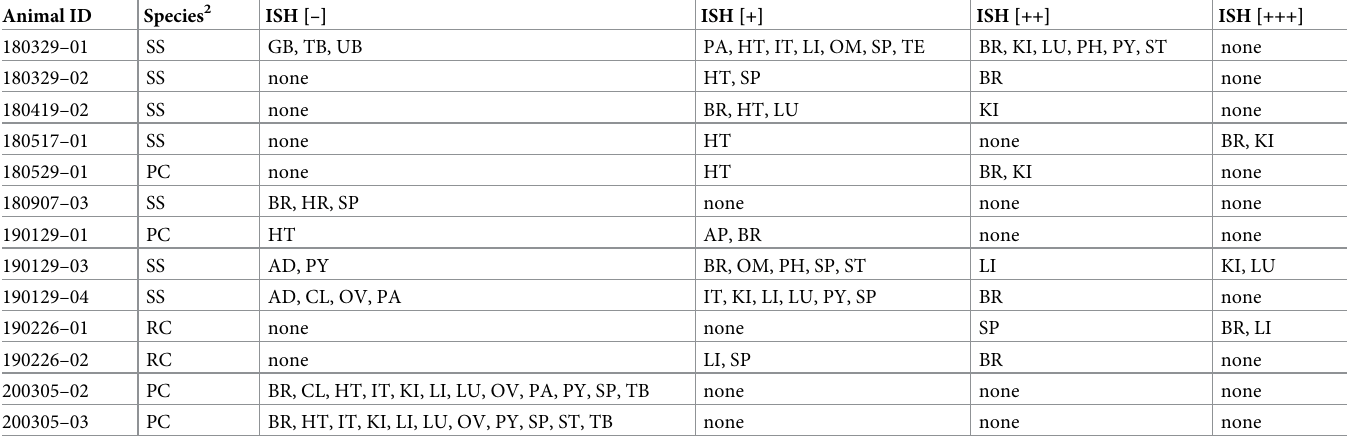
Table 4. In situ hybridization (ISH) results for tissues 1 examined from 10 TFV1 RT-PCR positive, and three TFV1 RT-PCR negative, freshwater turtles. Results are expressed as negative, ISH [–] or positive with the staining intensity subjectively indicated by the number of plus signs. none = no tissues qualified under the column head- ing